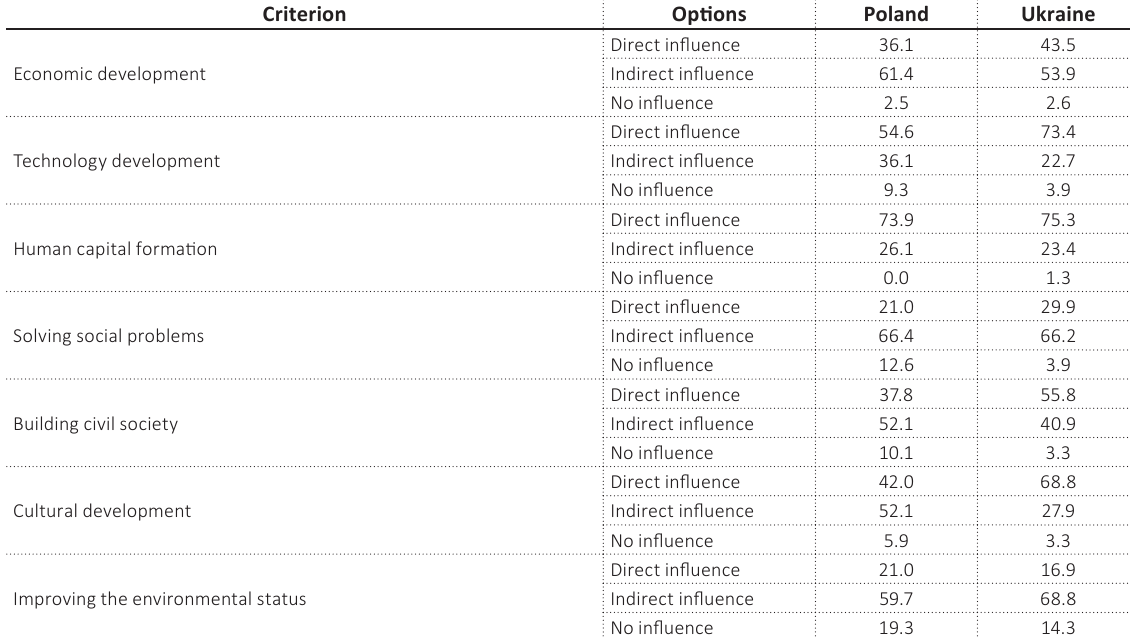
Source: Authors’ calculations based on own